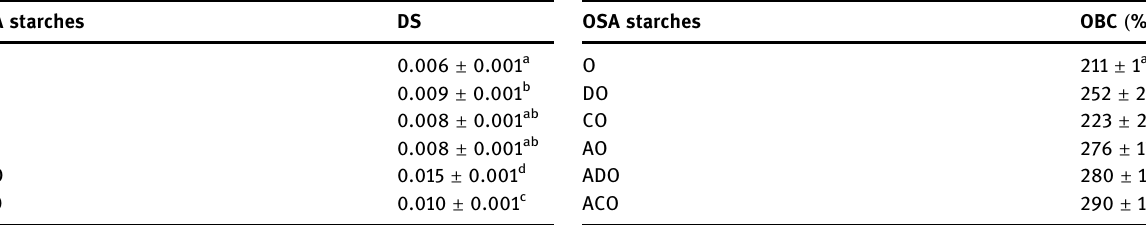
Table 1: Degree of OSA substitution ( DS ) of OSA starches OSA starches